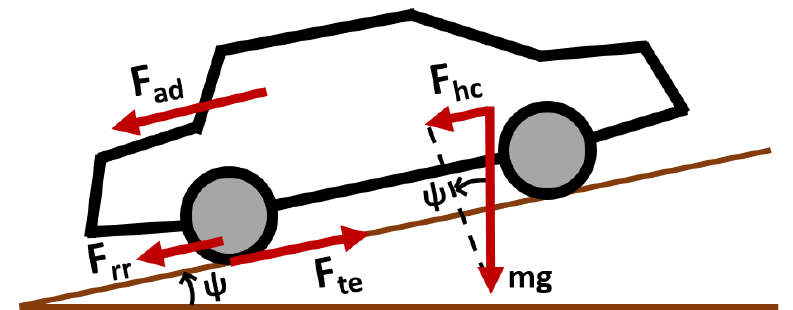
Figure 2. Review of the main forces acting on a vehicle.